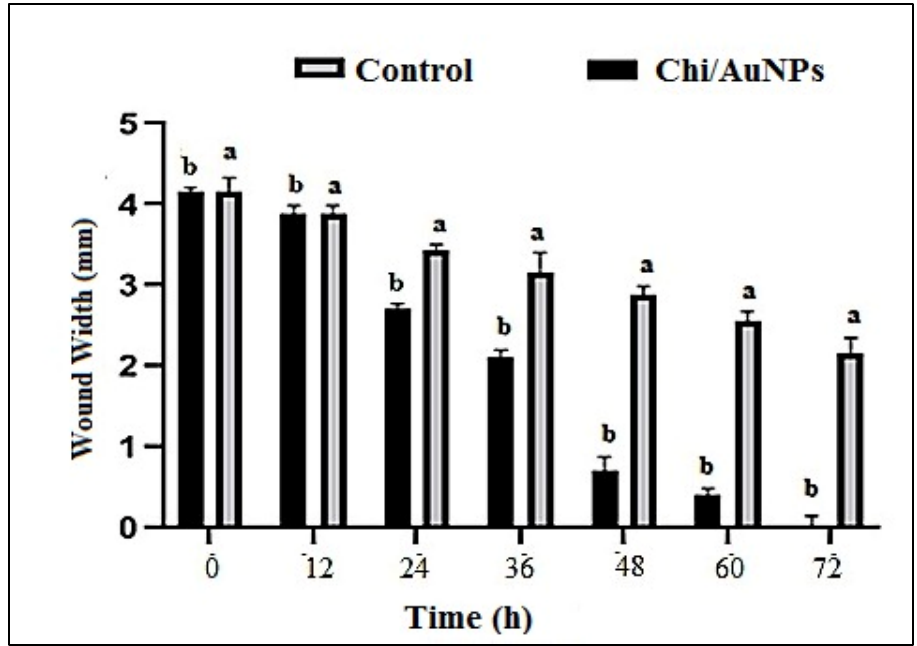
Figure 4. Effects of different treatments on wound area contraction (0–72 h). Values are given as mean ± SD (n = 3/group). Different letters indicate significant differences ( p < 0.05).